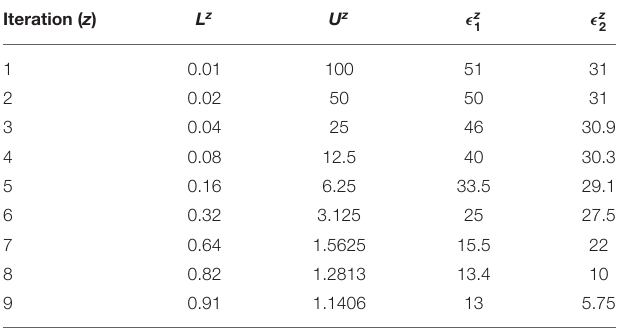
TABLE 4 | CRC parameters for model